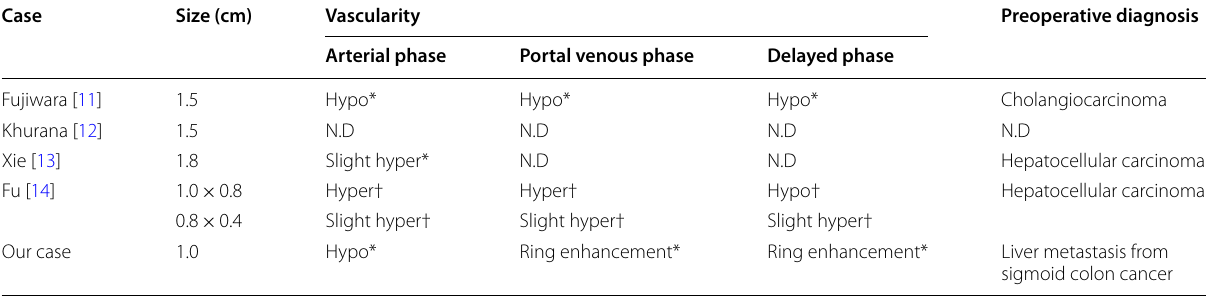
N.D not described